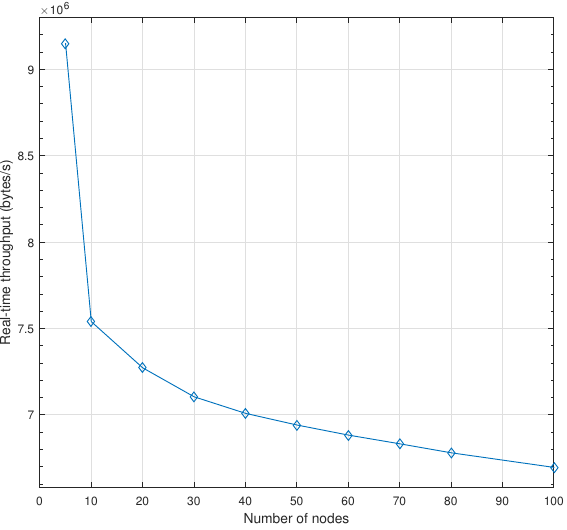
Figure 12. Real-time Throughput of AeroRing vs the network